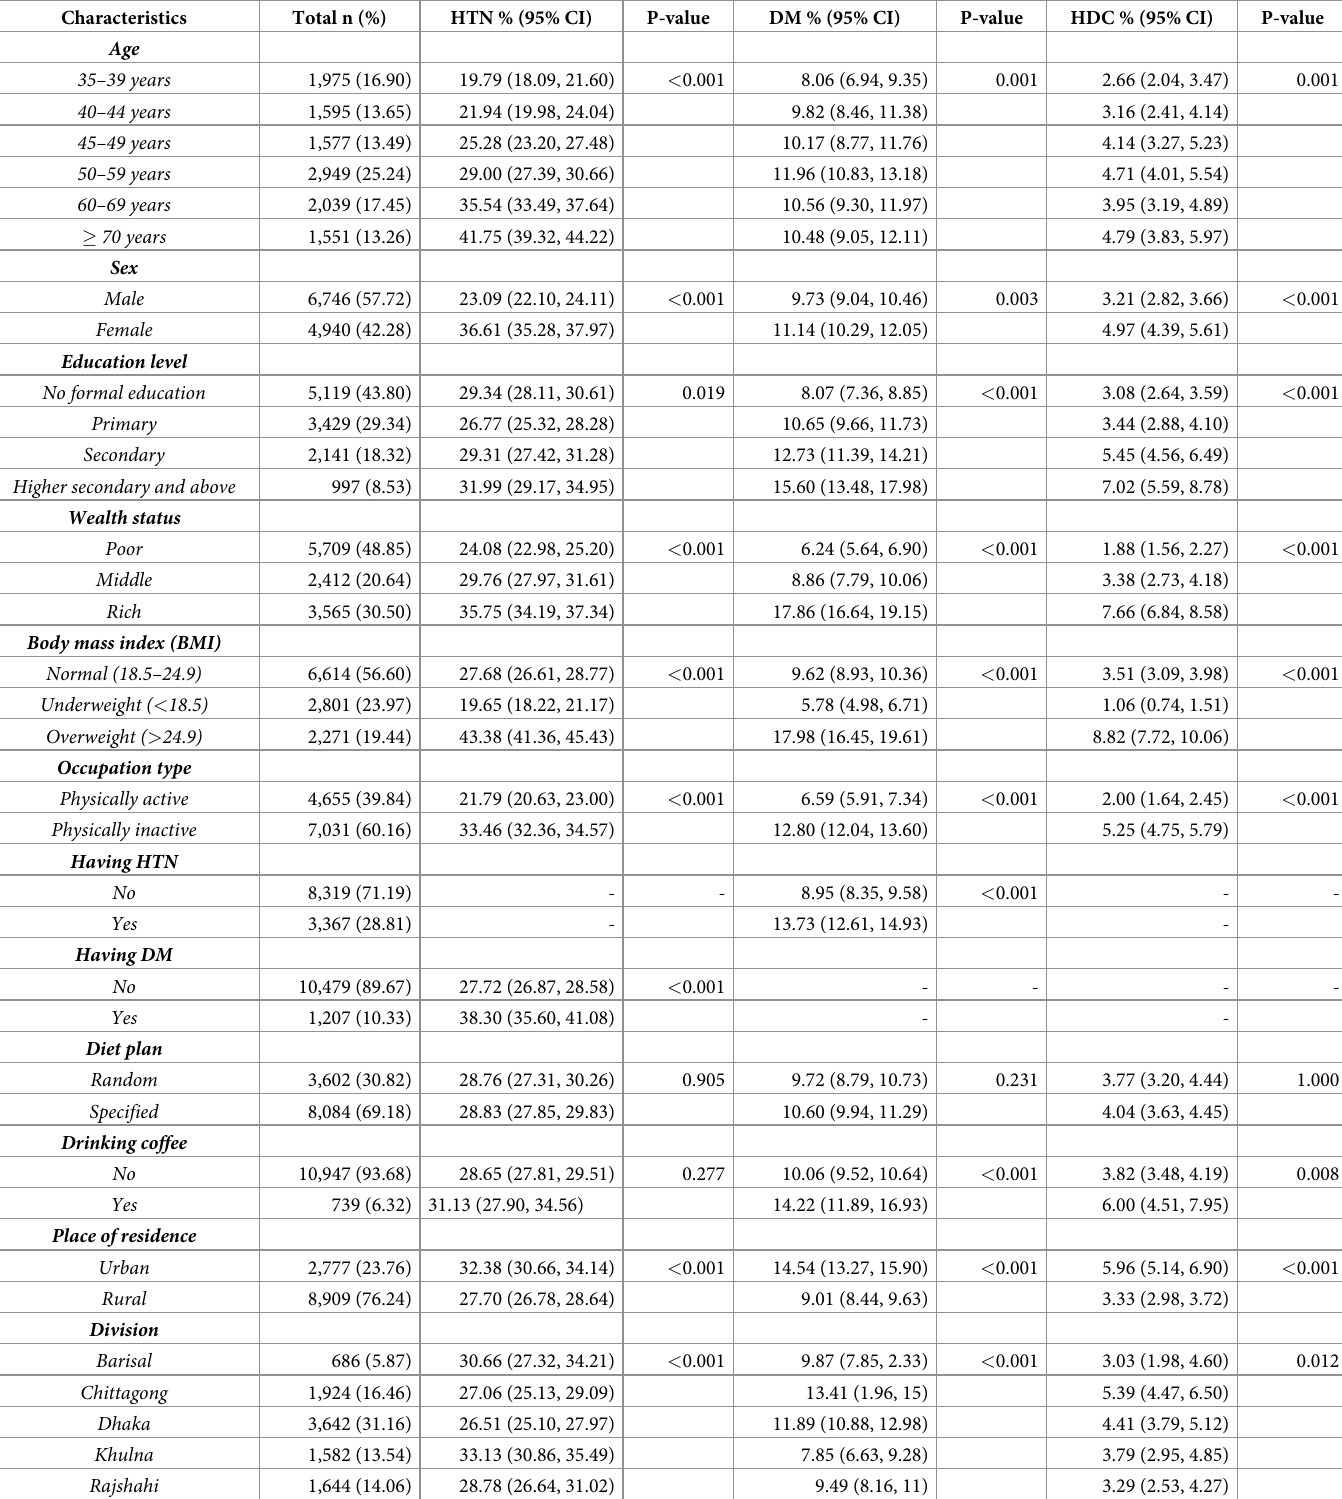
Table 2. The pooled weighted prevalence of HTN, DM, and HDC by selected covariates with Chi-square test in Bangladesh (2011–2018).